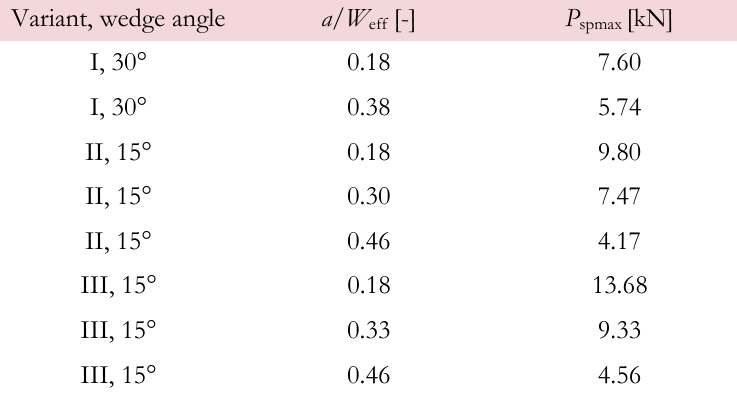
Table 3: Variants of evaluated experiments and corresponding wedge angle, and the relative notch length with maximal value of splitting force (both values are mean values from 3 up to 6 measurements, see detail in [29].